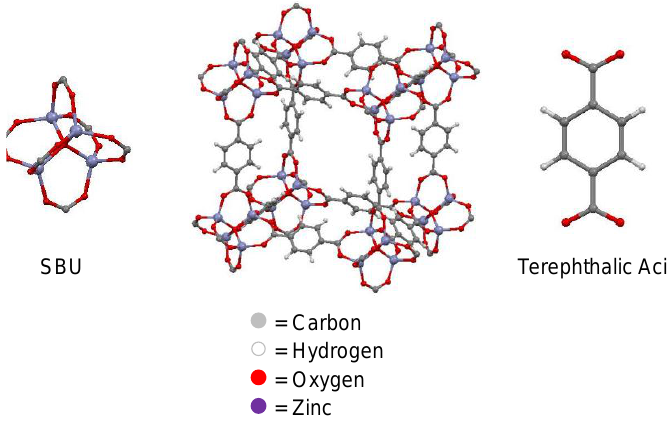
Figure 4. Schematic of the Metal-organic framework (MOF), MOF-5 produced from crystallographic data from [33].